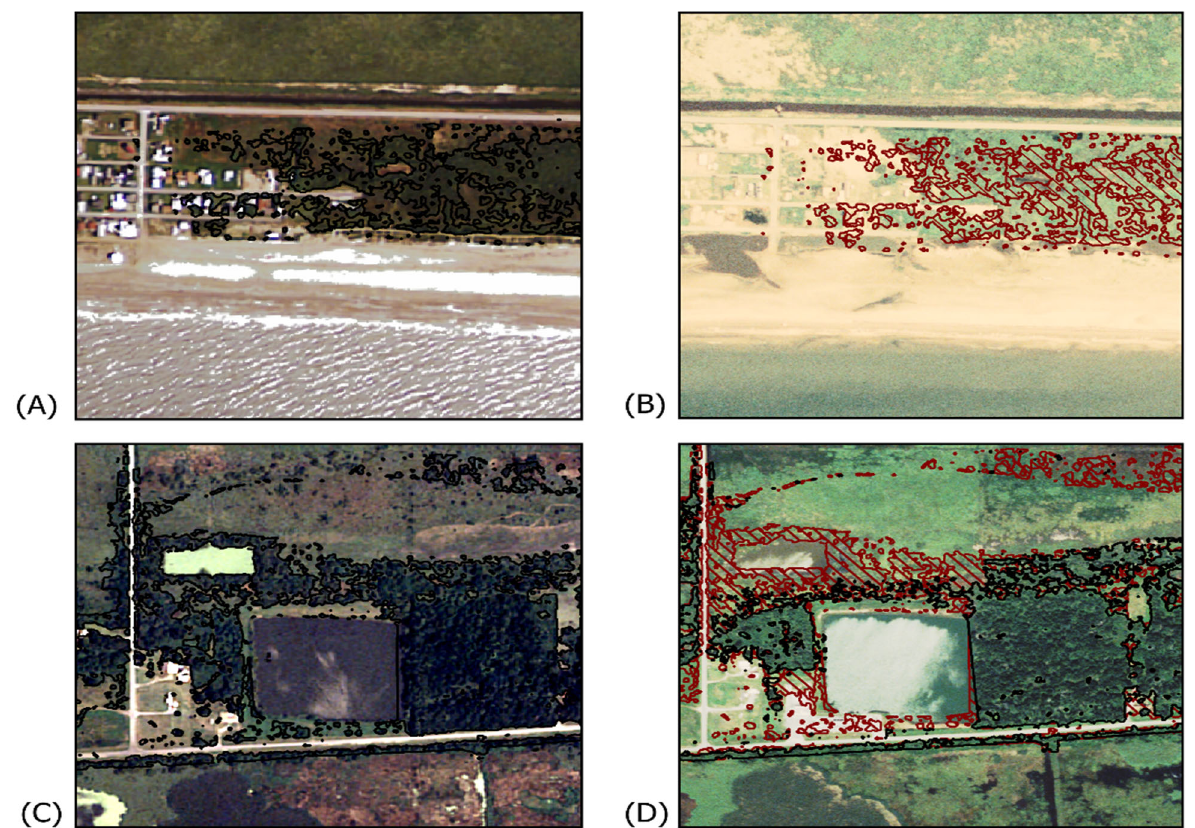
Figure 7. Visual depictions of two forms of loss, one from hurricanes on Hackberry Beach ( A , B ) and the other documenting whittling reduction ( C , D ). The left column displays 2003 NAIP imagery and the right is 2007 NAIP imagery. Black shaded areas indicate current year forest extent, red hashed areas indicate a loss.